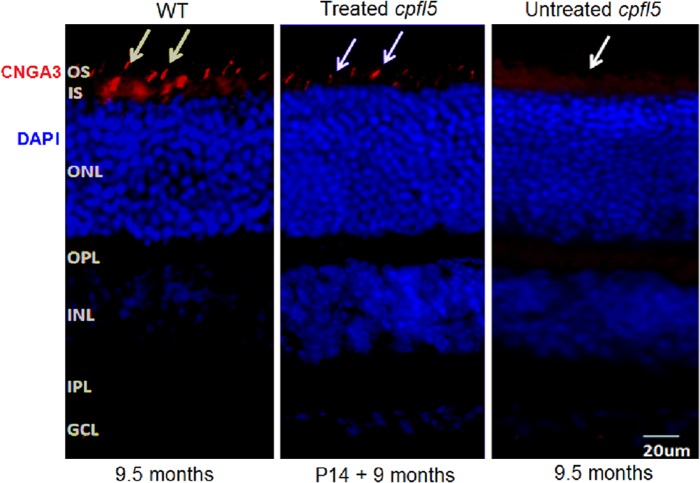
Long-term retinal CNGA3 expression mediated by AAV8 (Y447, 733F + T494V)-IRBP/GNAT2-Cnga3 treatment.At 9 months following subretinal injection, retinal cryosections were immunostained with anti-CNGA3 antibody. CNGA3 expression (red) was detected primarily in the photoreceptor OS (arrows) in the AAV8 (Y447, 733F + T494V)-treated cpfl5 retinas and age-matched WT controls, but not in the untreated cpfl5 retinas. OS, outer segment; IS, inner segment; ONL, outer nuclear layer; OPL, outer plexiform layer; INL, inner nuclear layer; IPL, inner plexiform layer; GCL, ganglion cell layer. Nuclei were stained with DAPI (4′,6-diamidino-2-phenylindole) (blue).